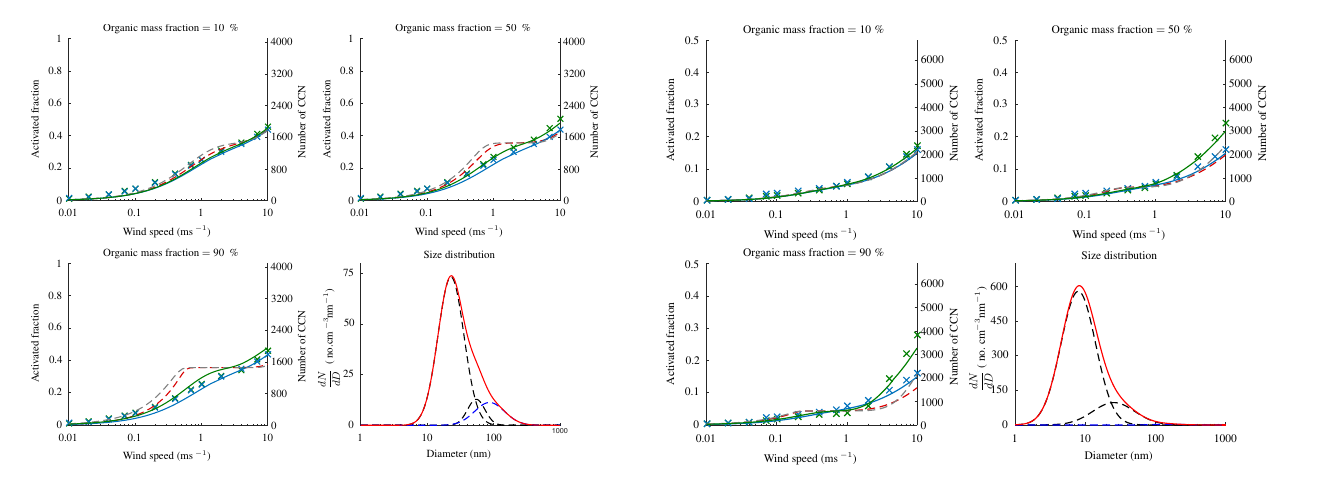
200 cm − 3 and a slightly lower number of CCN. The agree- ment between the parcel model and the parameterisation is excellent with a very slight underestimate at lower updrafts. The enhancement at higher updrafts is captured almost ex- actly. At very high concentrations, however, the parcel model predicts very little increase in the number of CCN from the SVOCs while the parameterisation shows a noticeable en- hancement. Overall, the agreement is still very good and the errors from the new parameterisation with SVOCs are not larger than those resulting from the Fountoukis and Nenes parameterisation without SVOCs. Fig. 8. The cloud base equilibrium parameterisation (dashed red) significantly over-predicts the number of CCN at lower updrafts due to there being more condensed mass on larger particles at equilibrium than is seen under dynamic condi- tions. This increases the size of the largest particles too much, allowing them to activate at lower supersaturations. The same effect can be seen in Fig. 7 below 0.2 m s − 1 . Conversely,